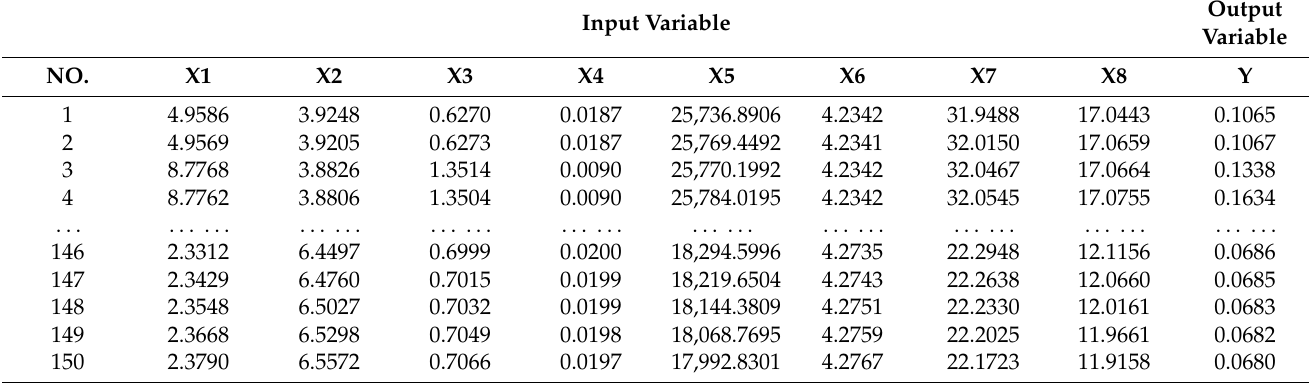
Figure 3. Comparison of measured and predicted values. Table 4. Corrosion data